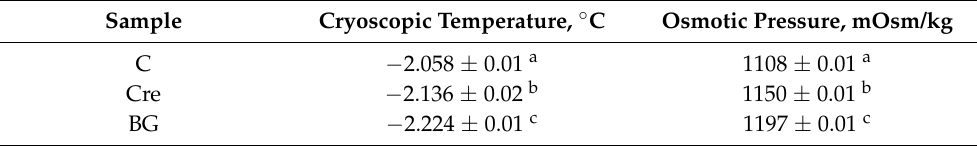
Table 3. Cryoscopic temperature and osmolality of milky ice cream. Sample Cryoscopic Temperature, ◦